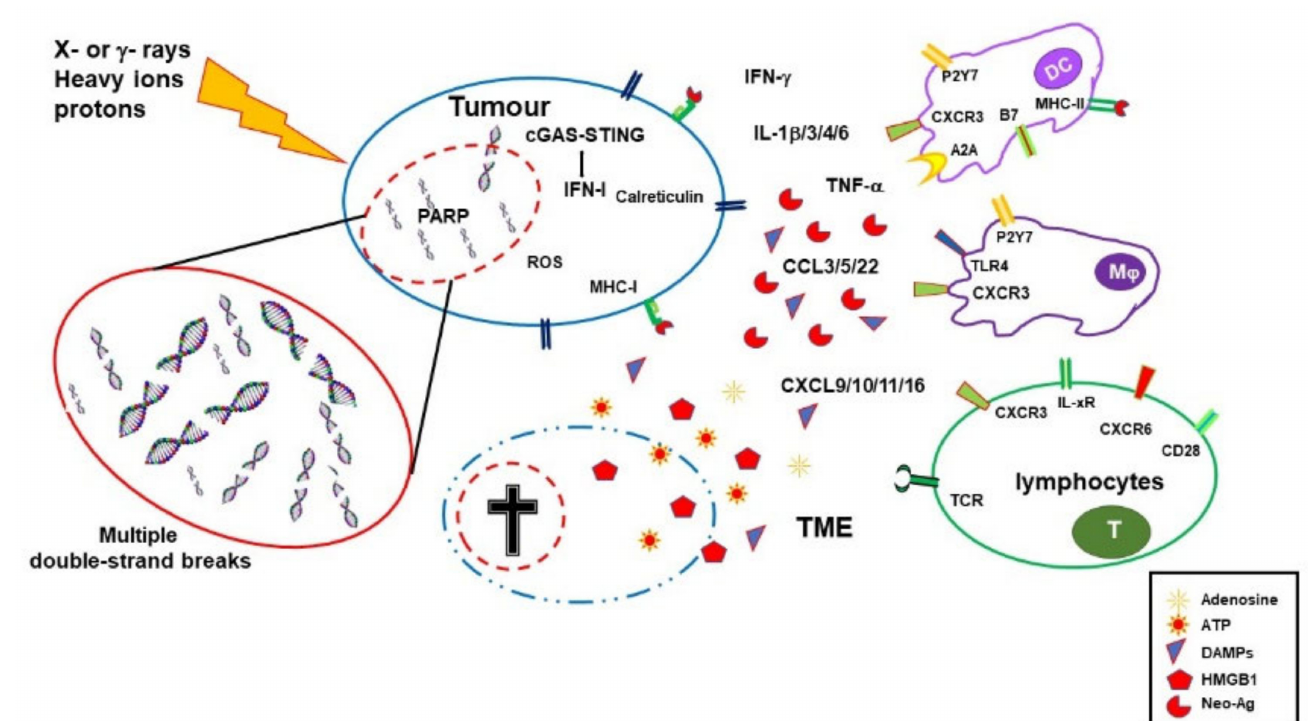
Figure 1. Immuno-stimulating effects of radiotherapy. Ionizing radiations (IRs) induce DNA damage, oxidative stress, and cell death. Dying cells release HMGB1 and ATP, and then expose calreticulin on their cell surface, all these molecules being features of immunogenic cell death. Damaged DNA activates the cGAS/STING pathway, leading to IFN-I expression, upregulation of MHC I expression, and improved antigen presentation in surviving cells. IRs also alter the tumor microenvironment (TME) by inducing the expression of several cytokines and chemokines with consequent recruitment of leukocytes. Tumor cells might accumulate mutations and express neoantigens which are taken up by dendritic cells (DCs) that, in the presence of the inflammatory stimuli, mature and migrate to the draining lymph node where they prime tumor antigen-specific CD4 and CD8 T